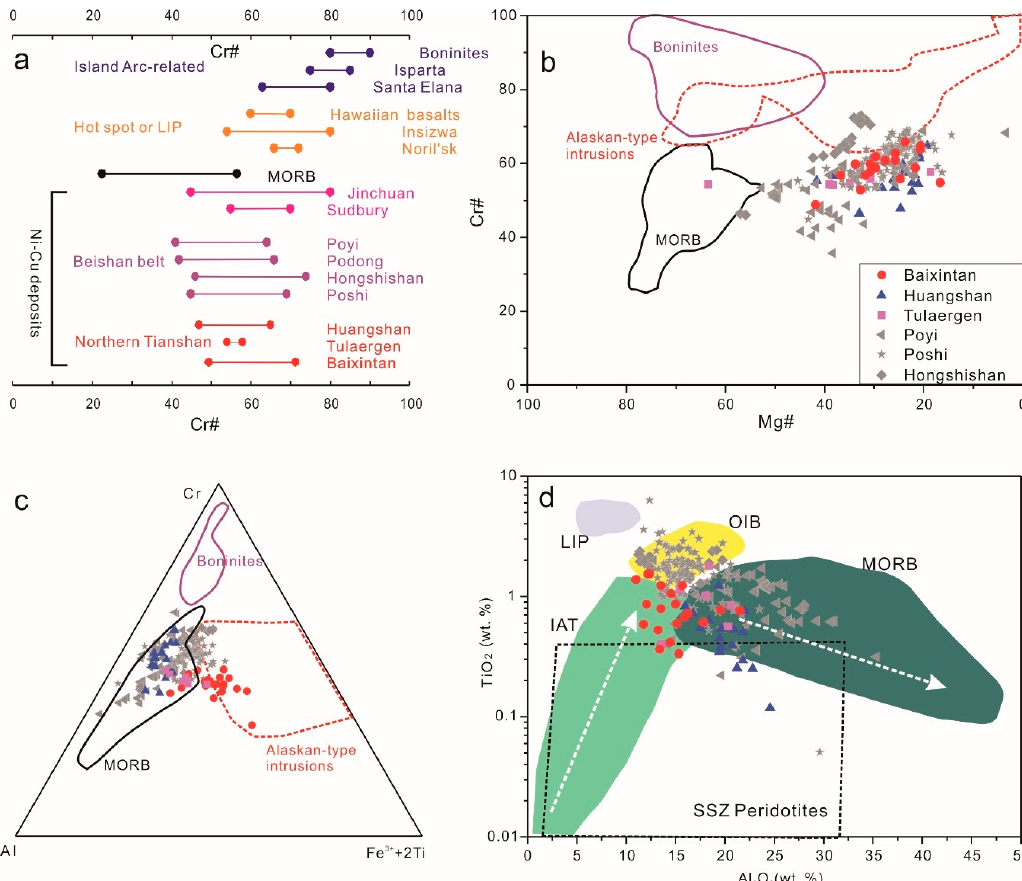
Figure 5. Chromite composition in the Baixintan (only Chr I) and other mafic-ultramafic intrusions in the Northern Tianshan and Beishan: ( a ) the Cr# range in island arc-related intrusions, hot spots or LIP, and Ni–Cu deposits; ( b ) a diagram of Cr#–Mg#, fields for boninites, and the middle ocean ridge basalt (MORB) from Barnes and Roeder [50], and Alaskan-type intrusions from Zhou et al. [19]; ( c ) a Cr–Al–(Fe 3+ + 2Ti) ternary diagram, with the references of fields the same as in ( b ); and ( d ) a plot of Al 2 O 3 –TiO 2 constraining tectonic setting. The chromite compositional fields for MORB, ocean island basalt (OIB), island-arc tholeiite (IAT), supra-subduction zone (SSZ), and large igneous provinces (LIP) are from Kamenetsky et al. [8]. Data of the other intrusions in Northern Tianshan and Beishan are from references [20,51,52].